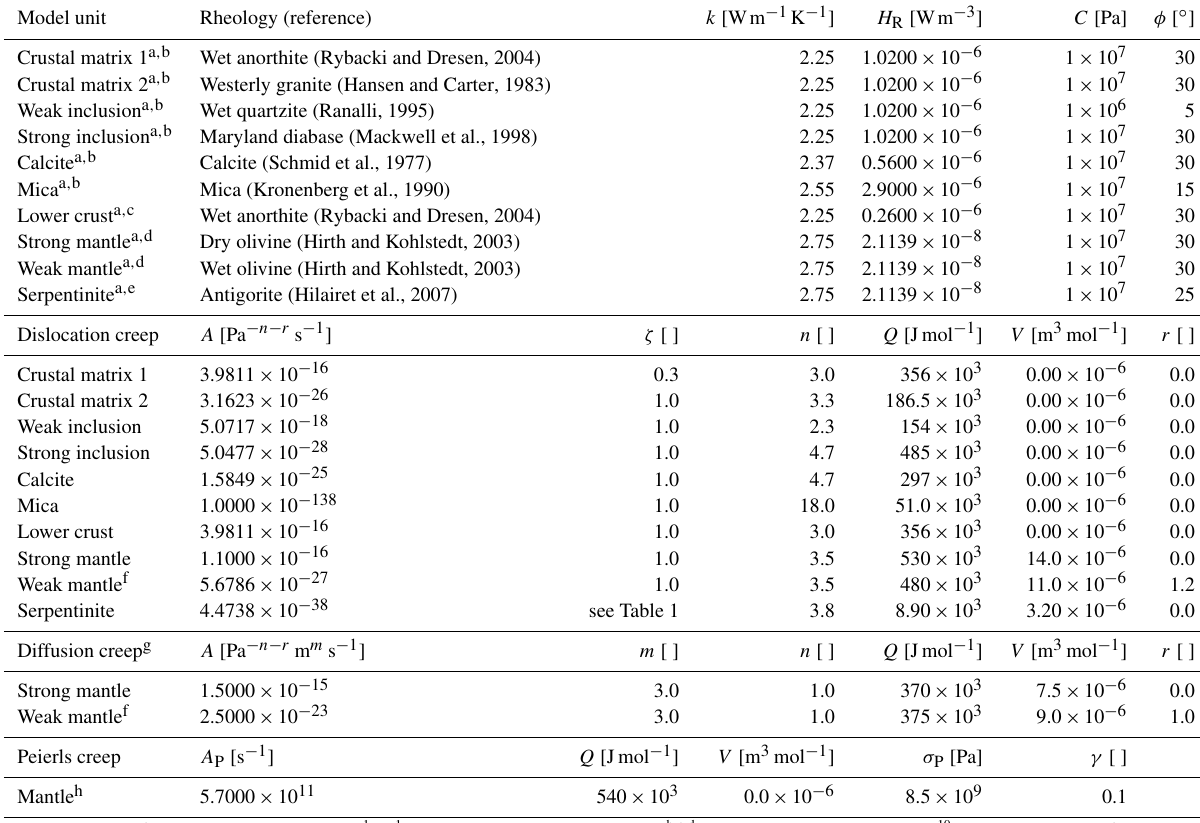
Table A1. Physical parameters used in the numerical simulations presented here. Model unit Rheology (reference) Crustal matrix 1 a ,